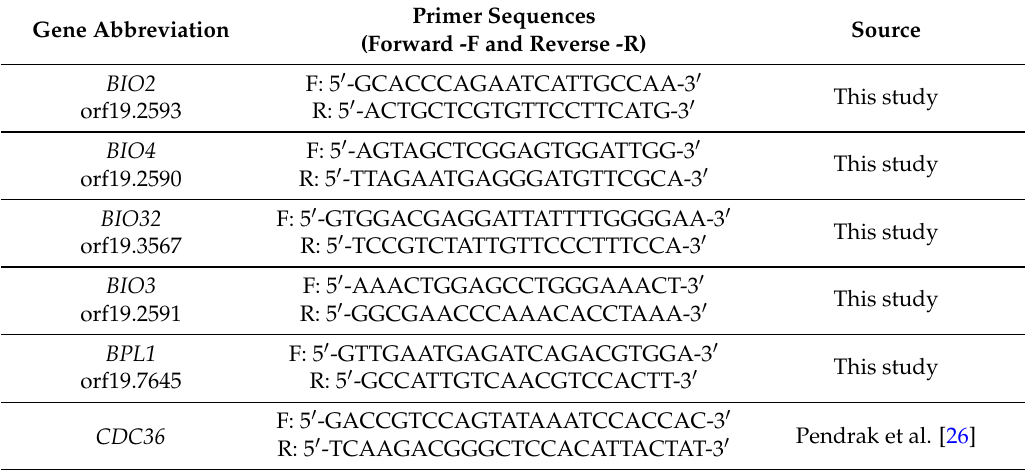
Table 2. List of primers used for gene expression. Amplification was done using CDC36 as the reference